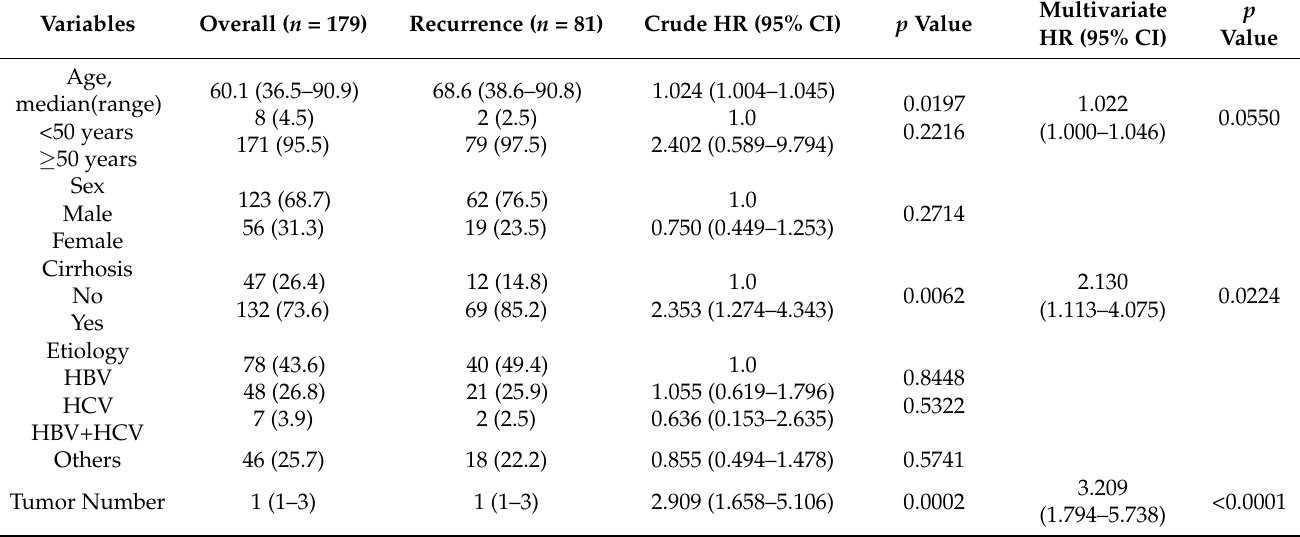
Table 2. Univariate and multivariate analyses of clinicopathological factors affecting HCC recurrence in patients after curative